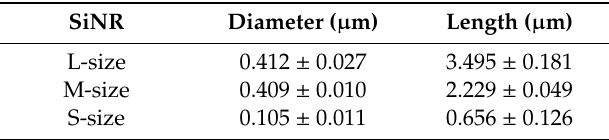
Table 1. Size parameters of the three types of